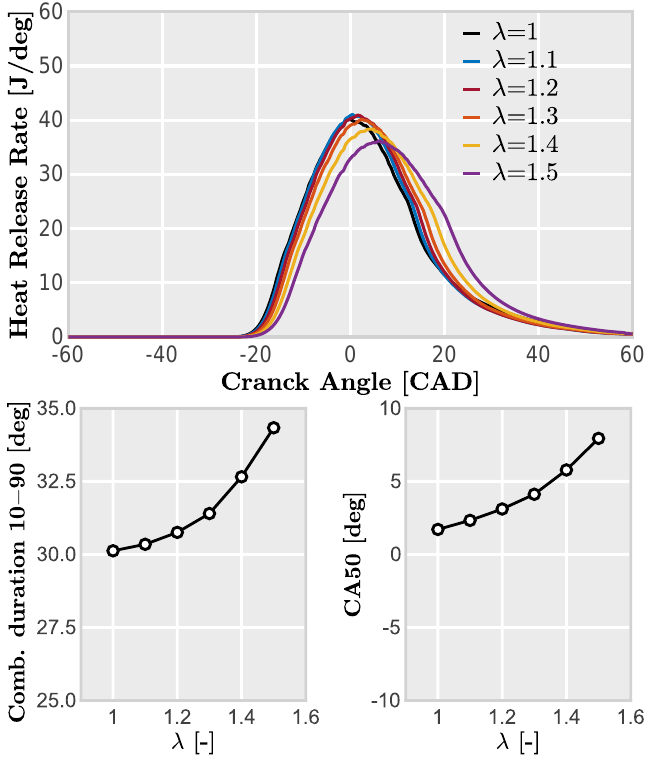
Figure 9. Trends of the main characteristics of the combustion process. Heat release rate profiles ( top ), combustion duration ( bottom-left ), and combustion phasing ( bottom-right ) for different air-to-fuel ratios considering methane